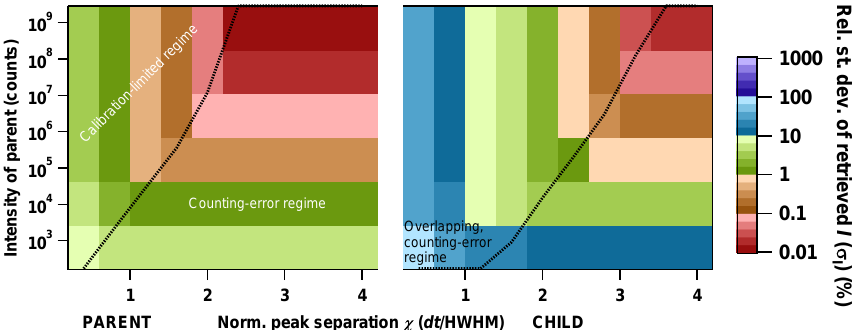
Figure 5. Actual precision in the normalised fitted peak intensities σ I for an overlapping ion pair. The stronger (parent) peak is 8 times as intense as the weaker (child) peak. The precision is represented by the colour scale and shown for a range of peak intensities and separations. The black lines denote the peak separation at or below which an ion would be considered to be in the calibration-limited regime.